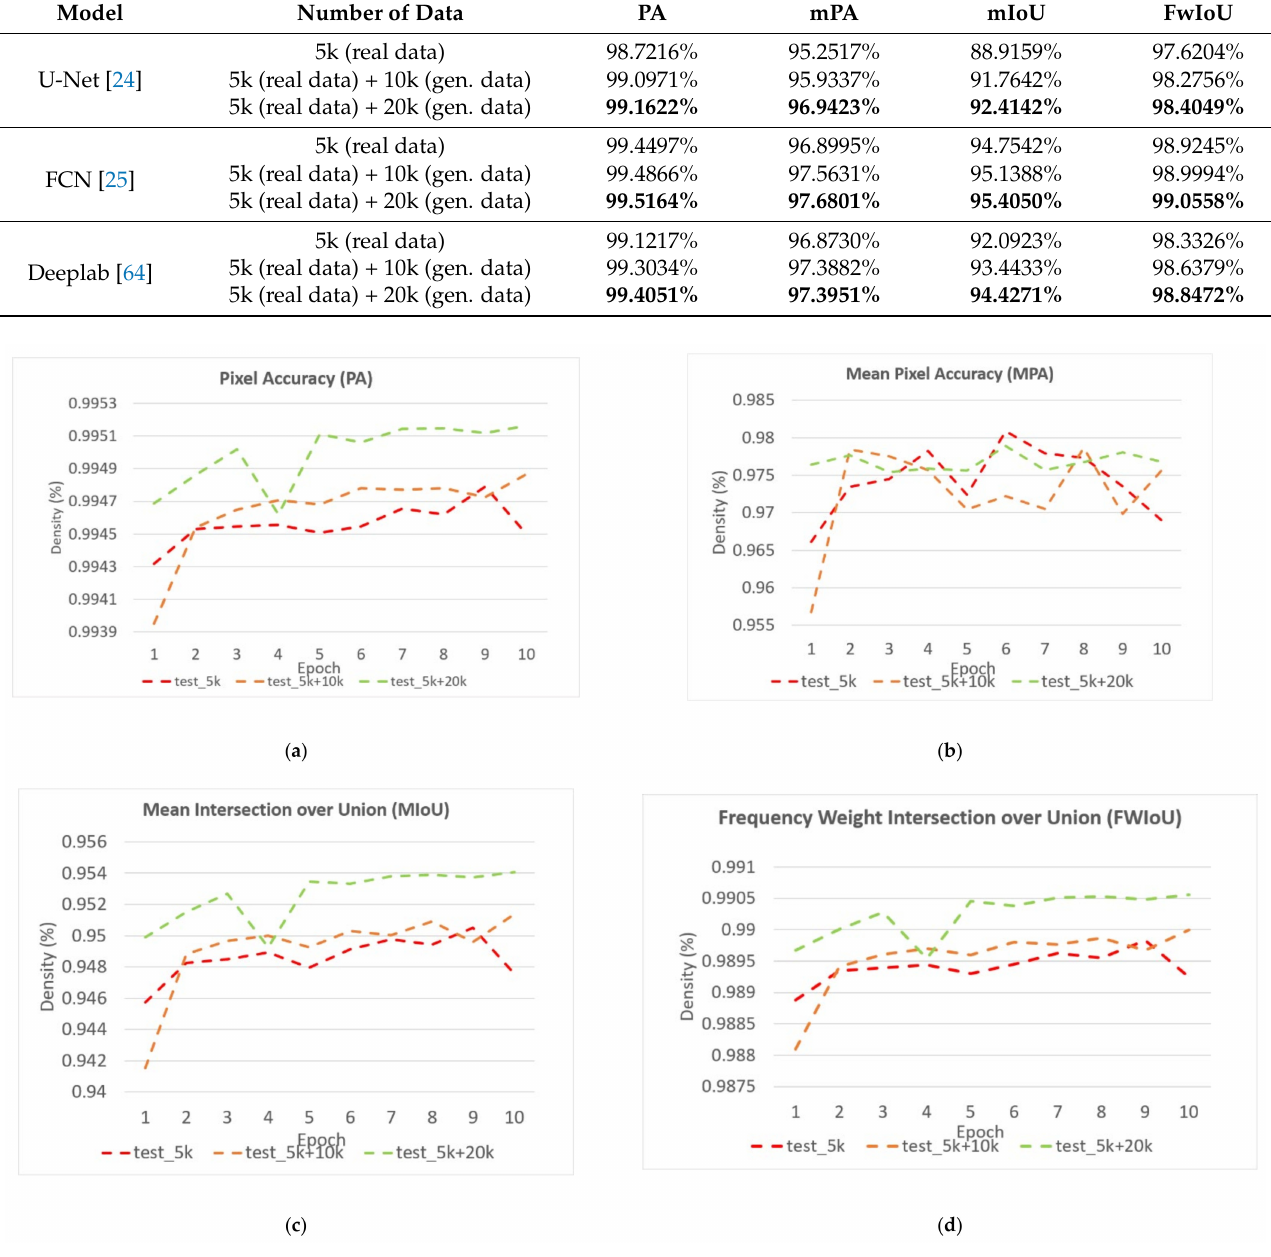
Table 3. The evaluation result of different algorithms on the customized dataset.